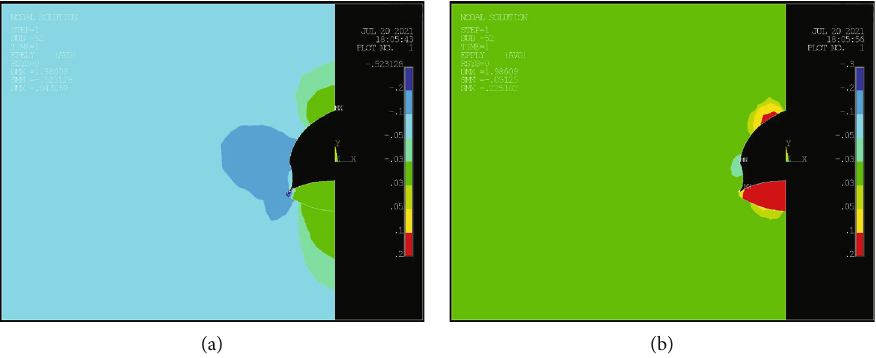
Figure 7: Maximum ( σ = 330 MPa). E wr